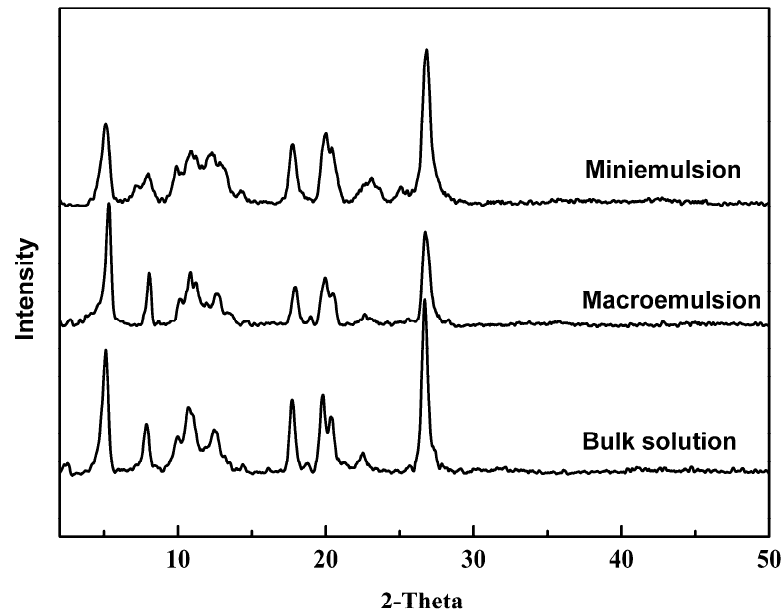
Figure 6. X-ray diffractograms of PR 146 obtained from the bulk solution, macroemulsion, and miniemulsion.